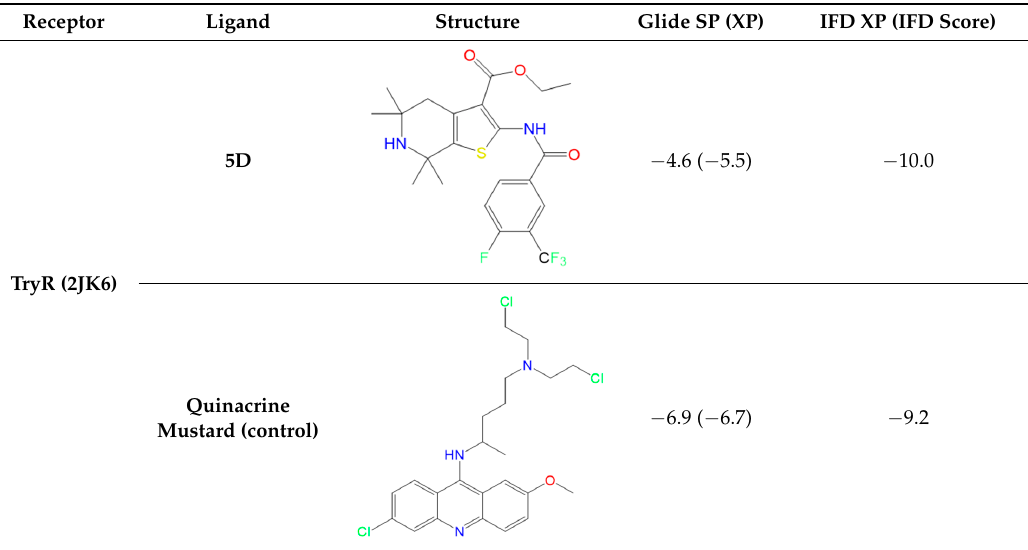
Table 2. In silico study of 5D and control Quinacrine Mustard.